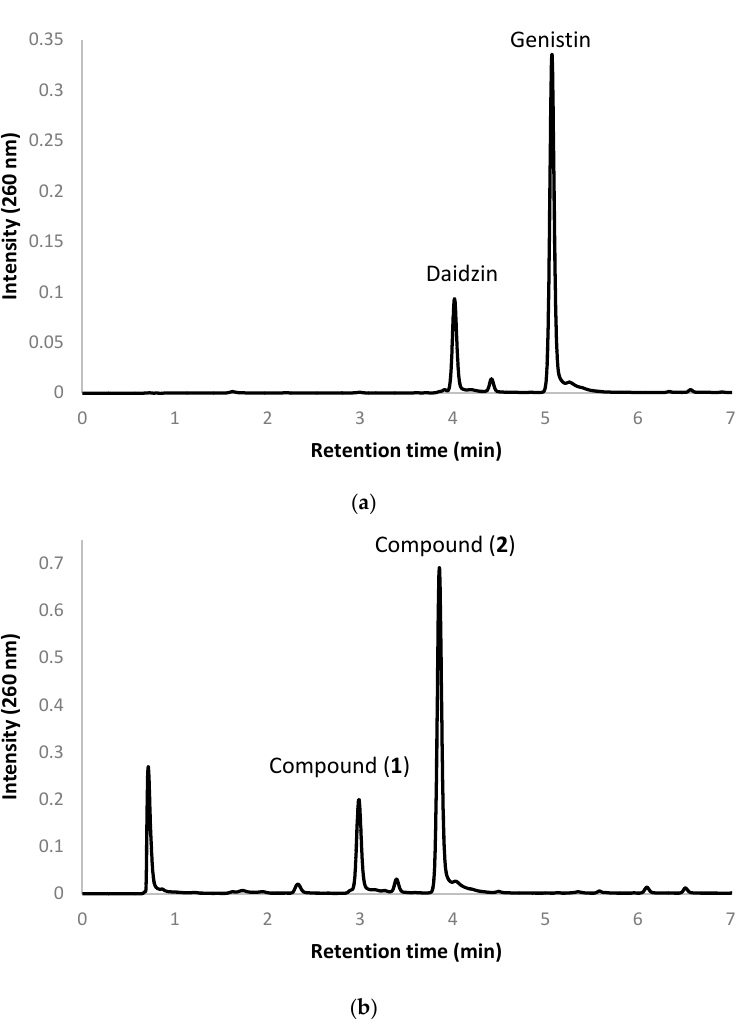
Figure 2. ( a ) UPLC profiles of the commercial soy isoflavone crude extract, and ( b ) the biotransformation after reaction with the recombinant E. coli for 1.5 h. The detailed protocols for biotransformation and UPLC are described in the Materials and Methods section.